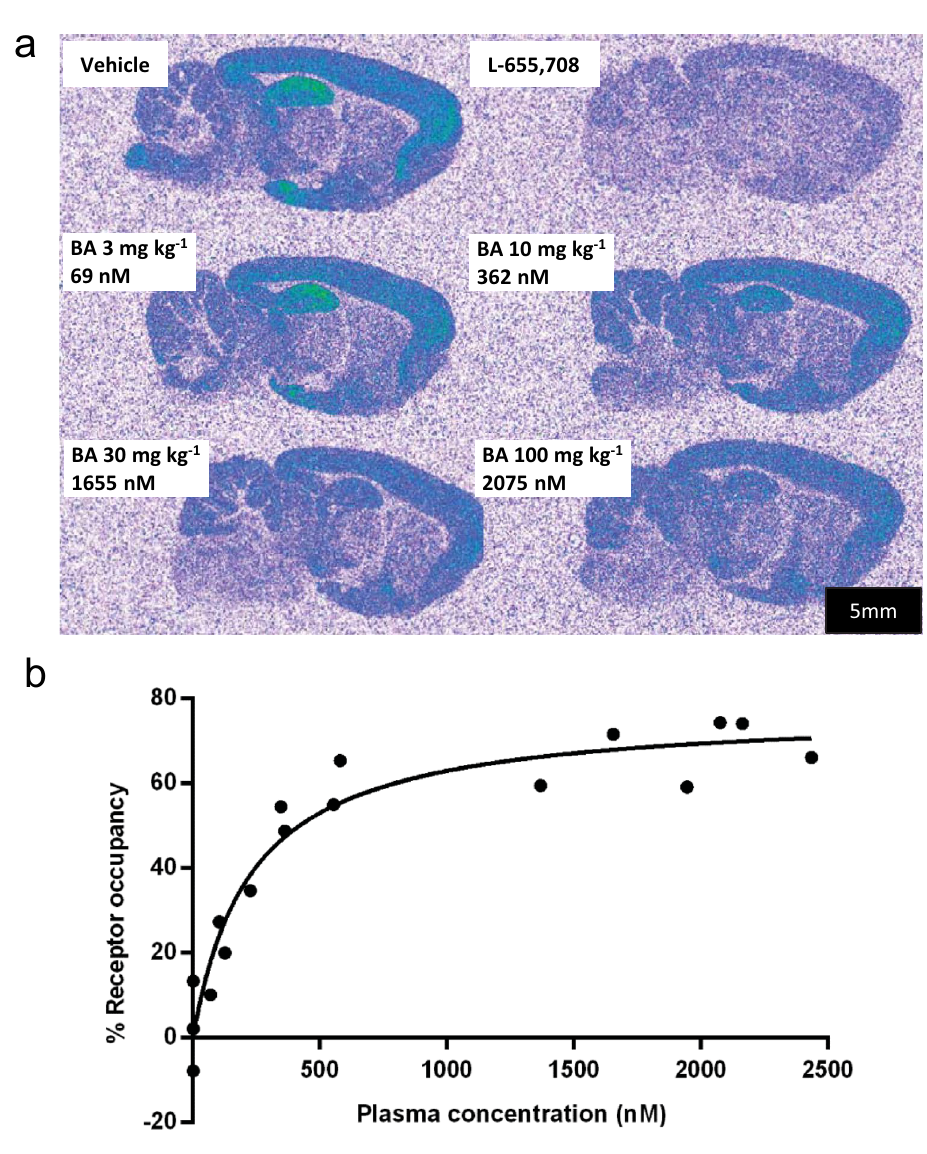
Figure 3. Dose-dependent GABA A -α5 receptor occupancy by basmisanil in rat brain. Dose-dependent blockade of [ 3 H]-Ro 15-4513 binding by basmisanil determined 60 min after p.o. administration of basmisanil and 15 min after i.v. injection of [ 3 H]-Ro 15-4513. ( a ) Sagittal brain sections of female Sprague–Dawley rats pretreated with vehicle (n = 4), L-655,708 (10 mg/kg; n = 4) or increasing doses of basmisanil at 3 mg/kg (n = 4), 10 mg/kg (n = 4), 30 mg/kg (n = 4) and 100 mg/kg (n = 2). ( b ) Quantitative autoradiography signals in